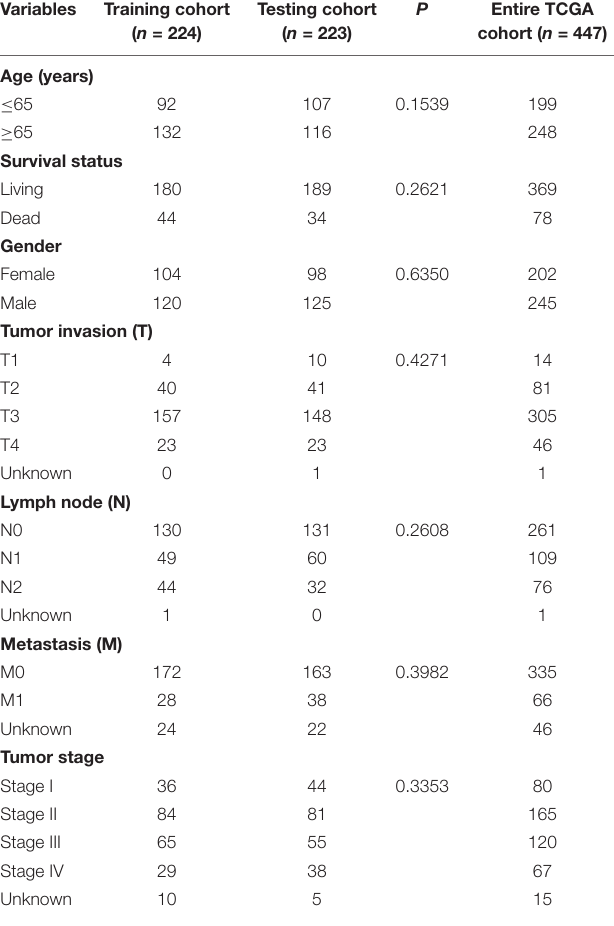
TABLE 1 | Clinical features of the colon cancer patients in each